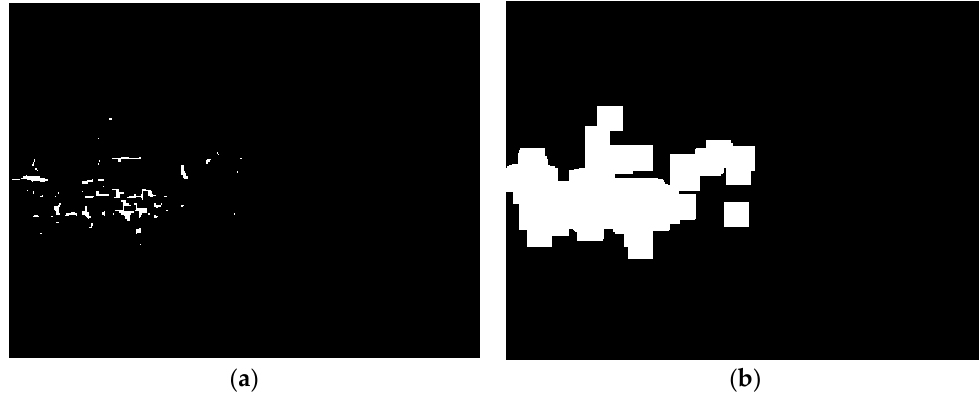
Figure 4. Morphological processing results of the binary image: ( a ) Corrosion operation; ( b ) Swell operation.